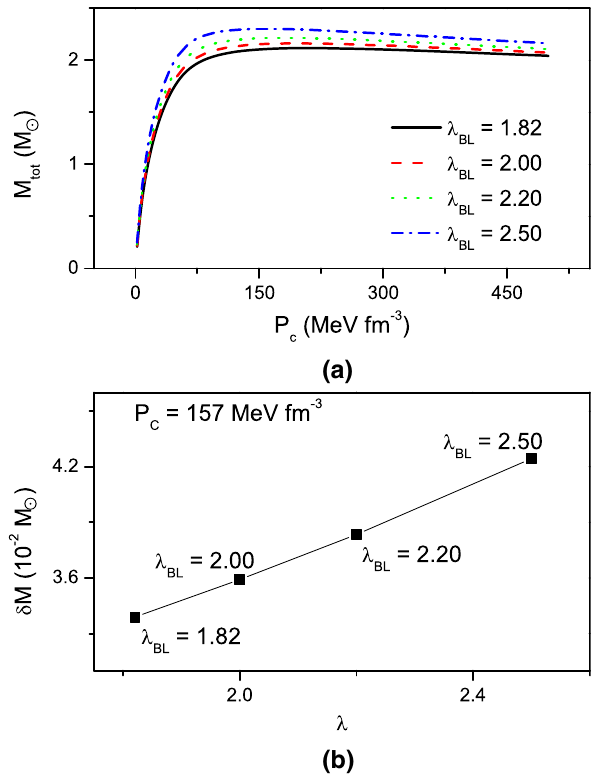
Fig. 2 Impact of anisotropic pressure on total mass and mass correc- tion of NS. The λ are specified in the figures. a The relation between the pressure at the center of the star and total mass. Maximum mass of NS with λ BL = 2 . 50 (blue dot-dash curve) exceeds 2.3 M (cid:2) . b Mass correction, i.e. δ M for different values of λ BL at P c = 157 MeV fm − 3 , which is the point where star with λ BL = 2 . 50 reach the higher value of mass